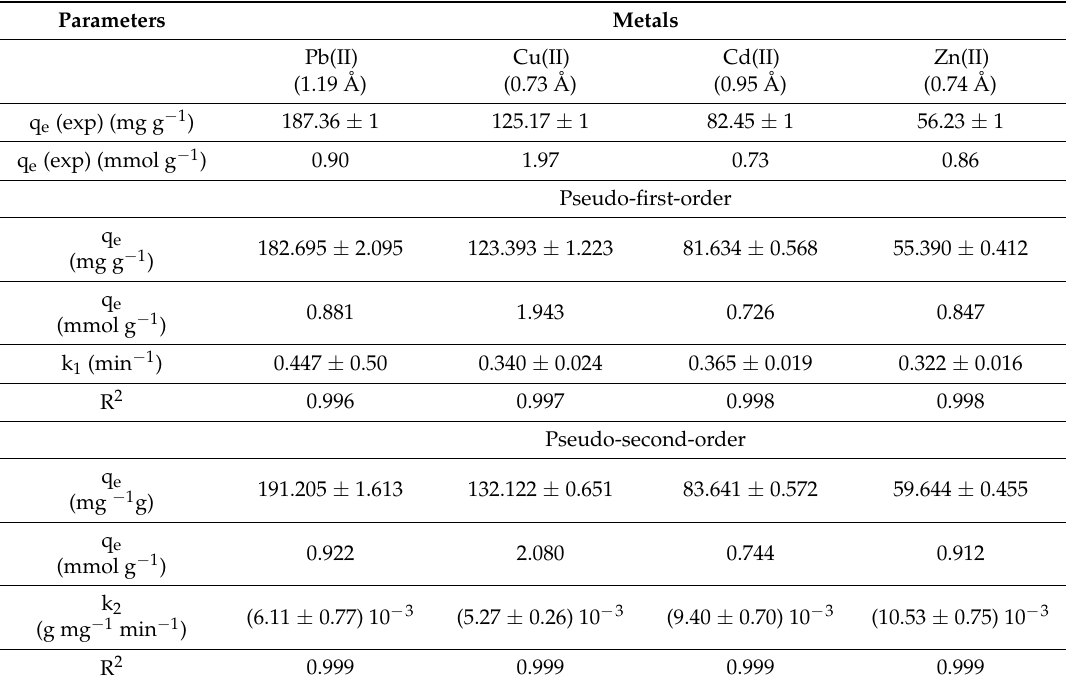
Table 3. Kinetics of heavy metals removal onto SiTF 5 PP